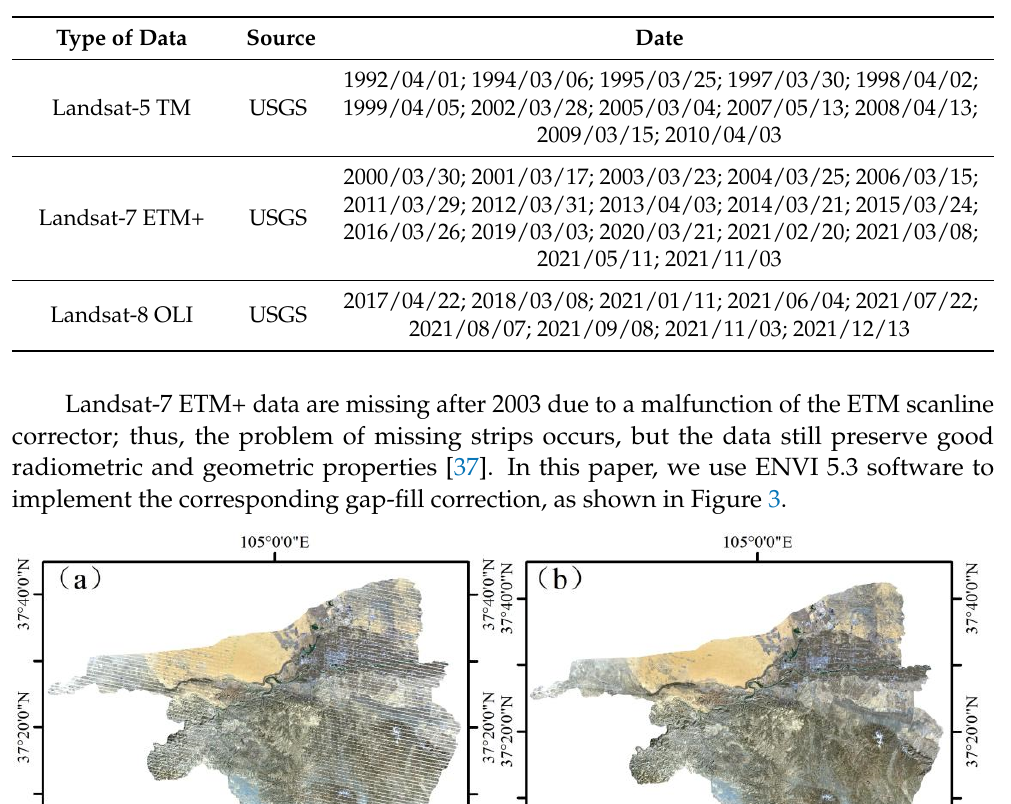
Table 1. Data used in the present study.